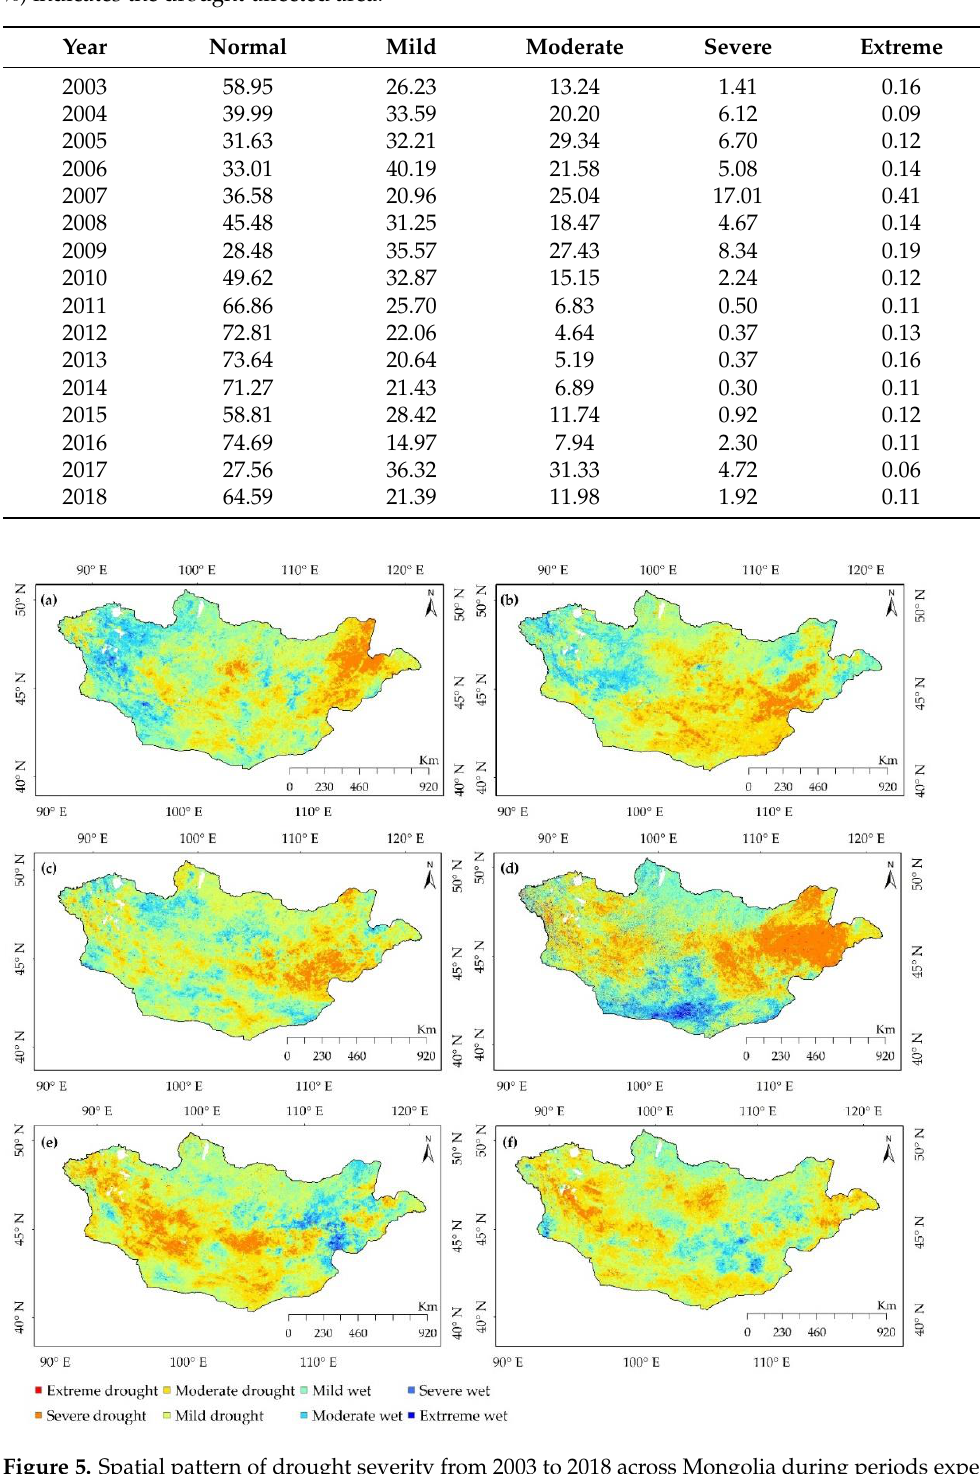
Figure 5. Spatial pattern of drought severity from 2003 to 2018 across Mongolia during periods expe- riencing the most drought: ( a ) May–September 2004, ( b ) May–September 2005, ( c ) May–September 2006, ( d ) May–September 2007, ( e ) May–September 2009, and ( f ) May–September